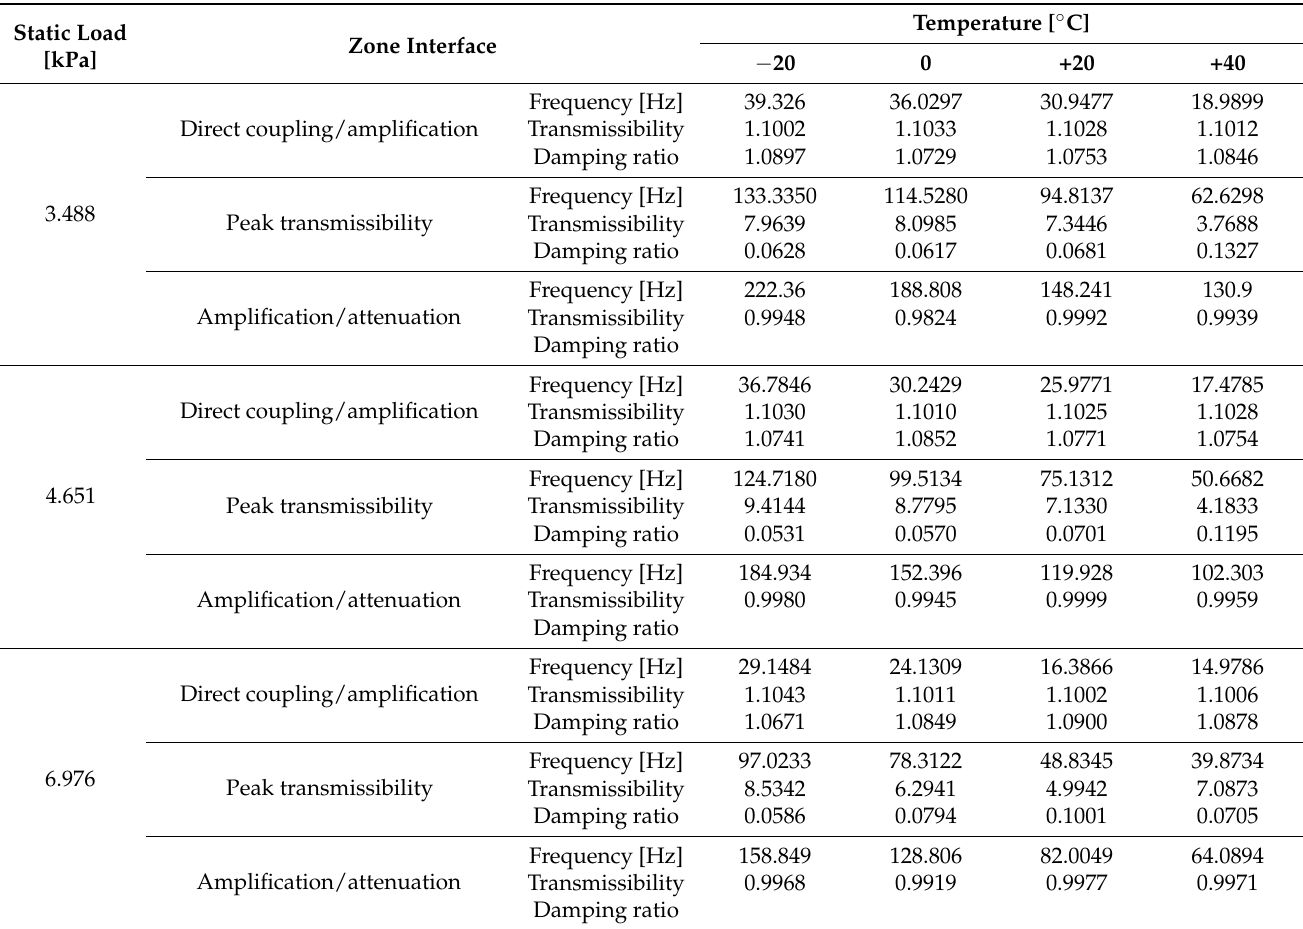
Table 4. Vibration transmissibility and damping ratio of XPE cushion